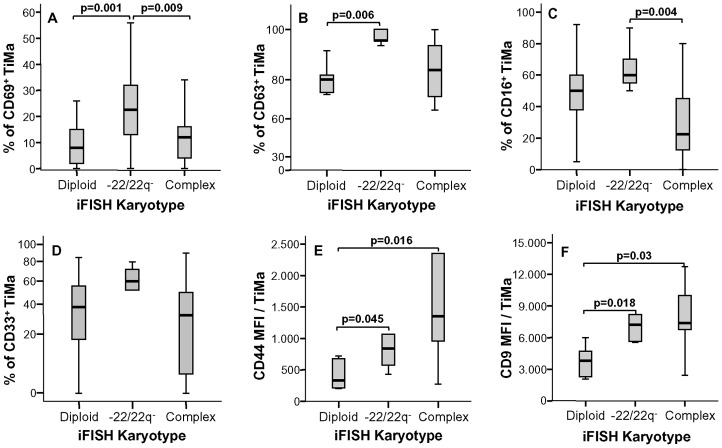
Immunophenotype of Tissue macrophages (TiMa) infiltrating meningioma samples, according to the cytogenetic profile of tumor cells.The percentage of TiMa expressing CD69 (panel A), CD63 (panel B), CD16 (panel C) and CD33 (panel D) are shown together with the mean amount of CD44 (panel E) and CD9 (panel F) expressed per TiMa infiltrating meningioma samples, according to the iFISH profile of tumor cells. MFI, mean fluorescence intensity (arbitrary fluorescence units) per cell. Notched-boxes represent 25th and 75th percentile values; the lines in the middle and vertical lines correspond to median values and the 10th and 90th percentiles, respectively.